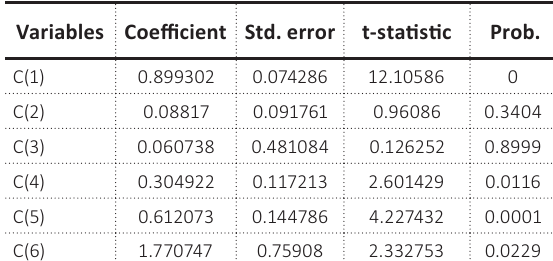
Table 4. Least squares estimates